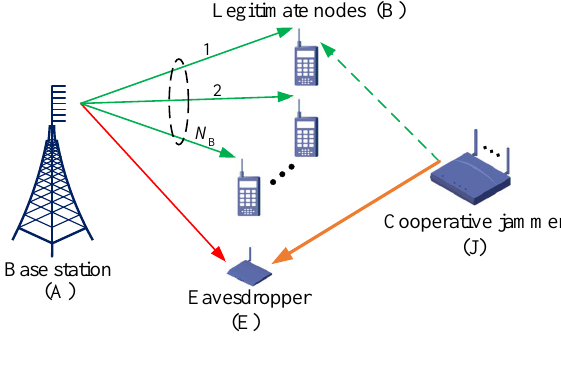
Figure 1. System